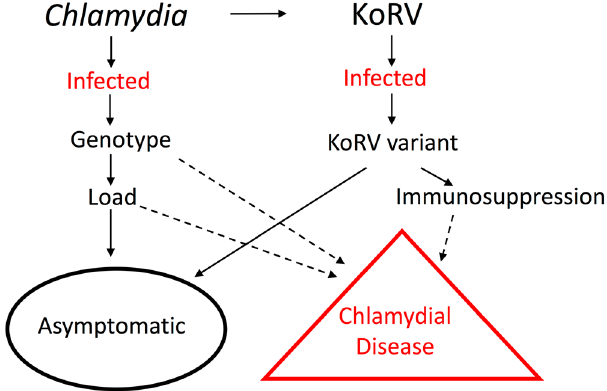
Figure 2. Conceptual model of the role that koala retrovirus (KoRV) may play in the progression of Chlamydia pecorum infection to clinical disease in the koala ( Phascolarctos cinereus ). Hypotheses are indicated with dotted arrows.